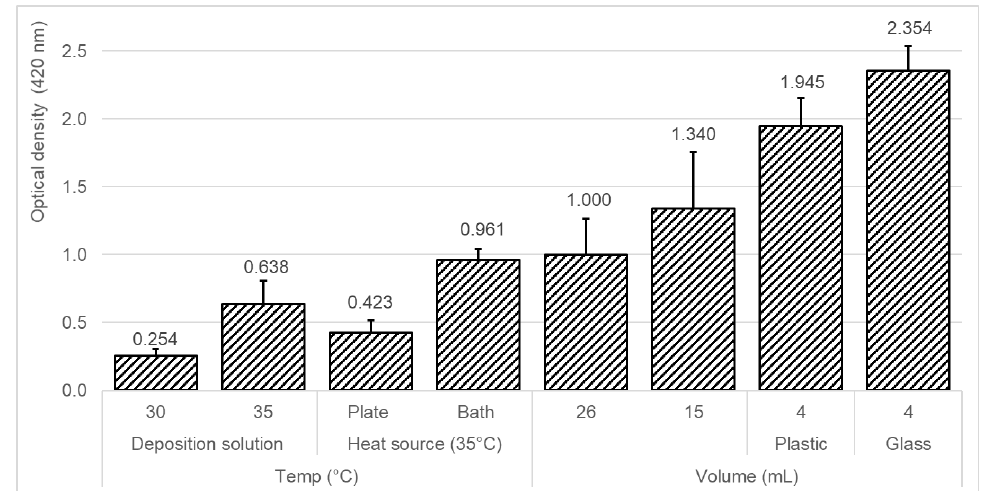
Figure 3. Effect of different deposition conditions on the efficiency of the silver-layer formation. Various parameters were examined including silver solution temperature and volume, heating mode, and the tank material. The silver-deposition reaction duration was 9 min in all the tested parameters.